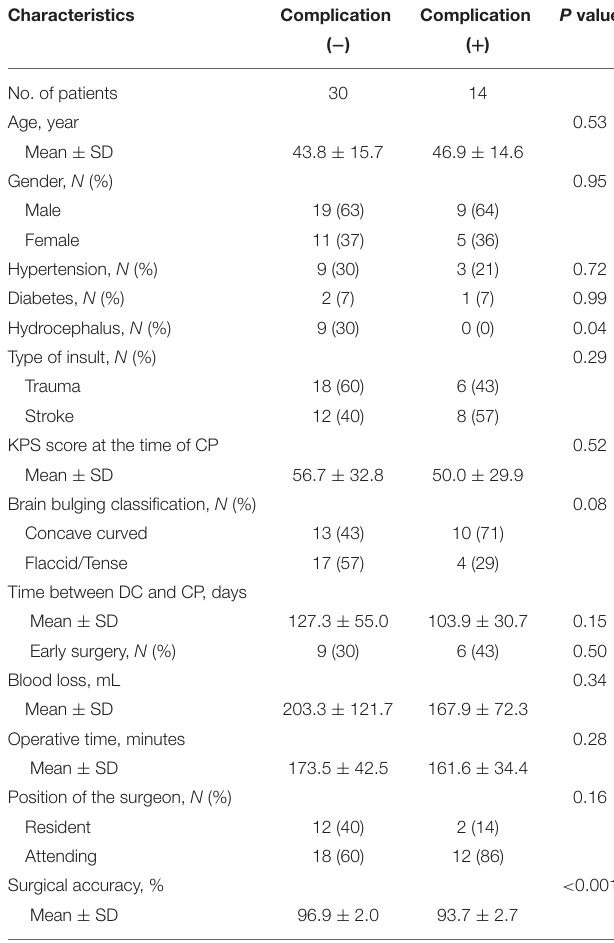
TABLE 5 | Univariate analysis for overall postoperative